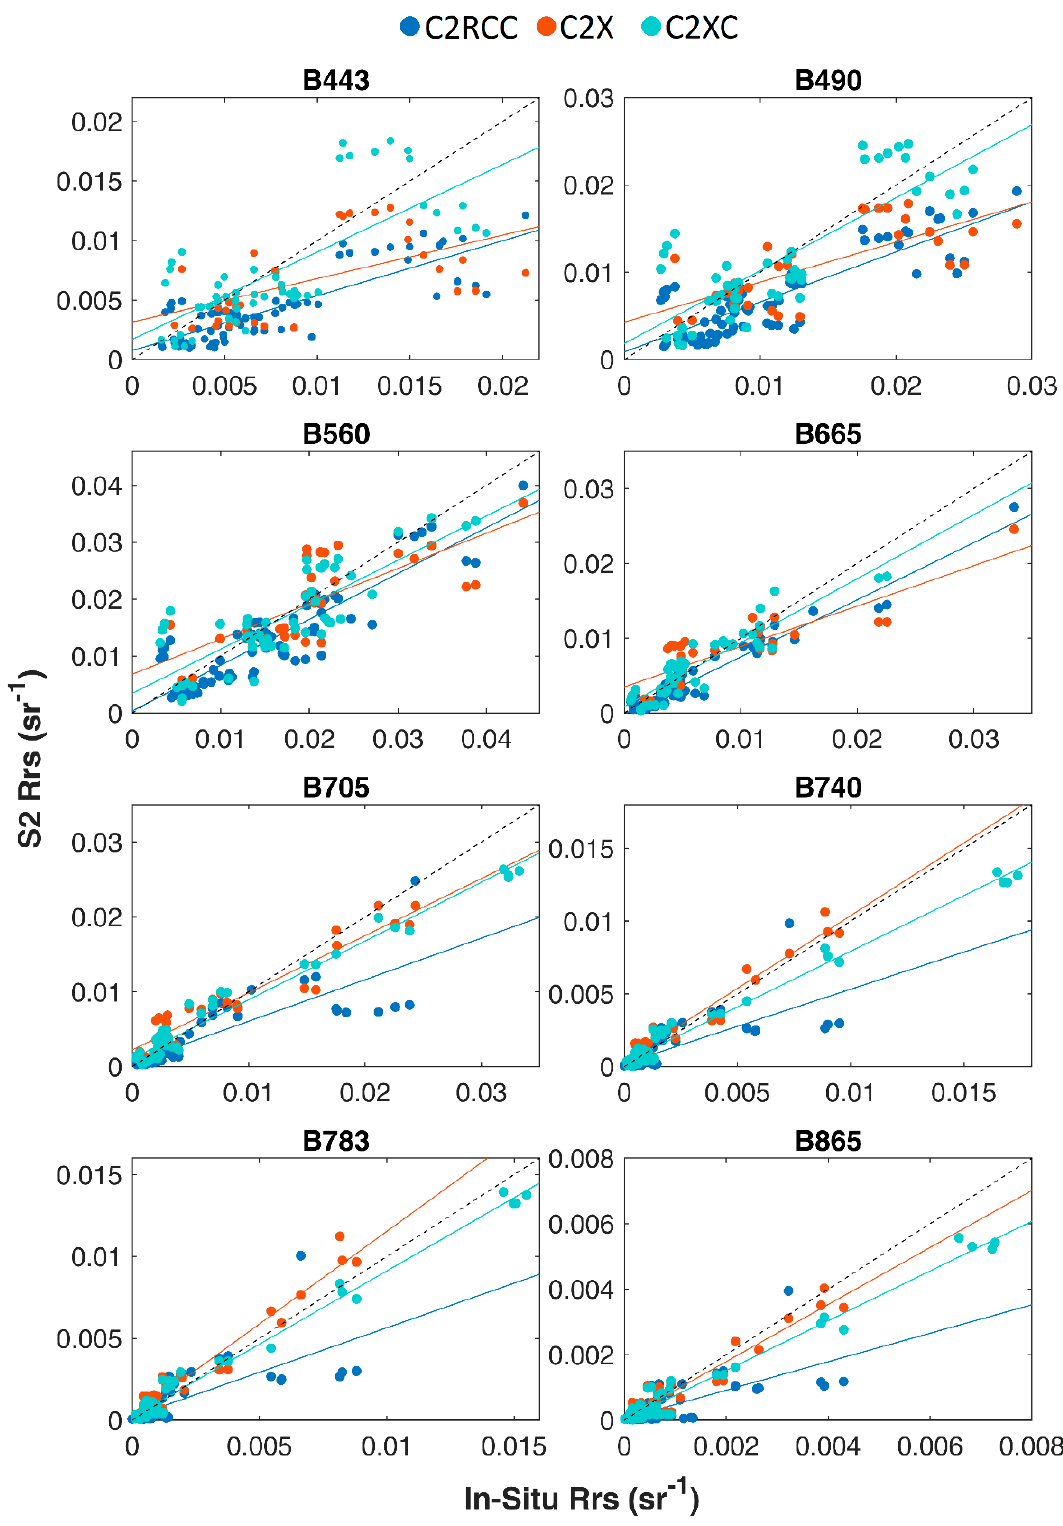
Figure A1. Scatter plots between measured and C2-Nets estimated Rrs at all available spectral bands. The dashed line corresponds to a 1:1 line.